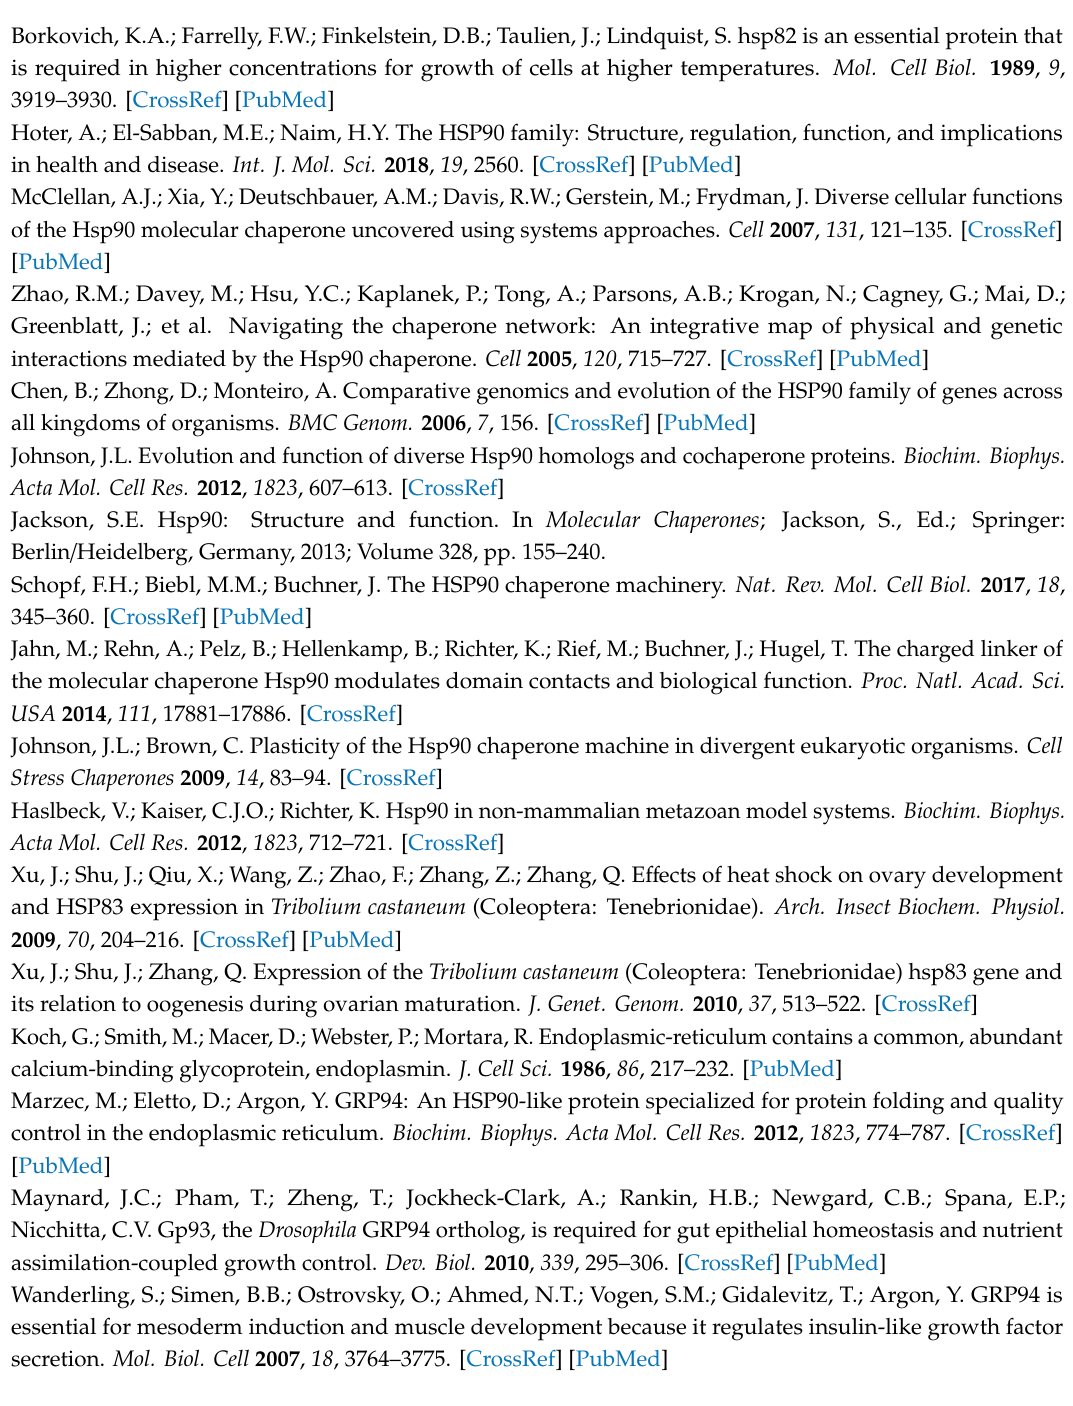
Table S1: The main primers used in this study, Table S2: The 34 Hsp90 homologs derived from 18